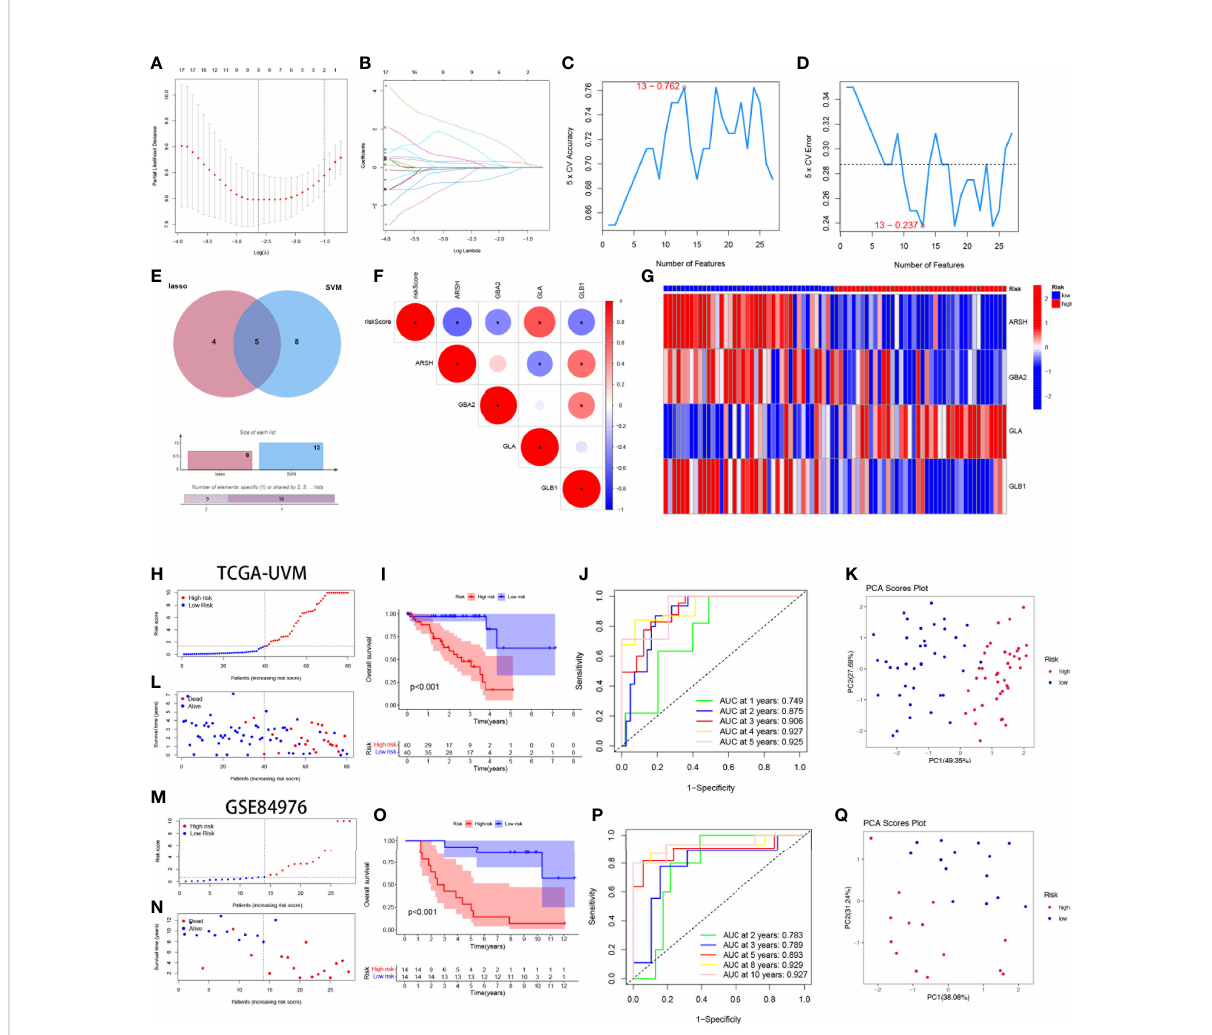
FIGURE 3 Construction and validation of 4-SMGs Signature. (A) Ten ‐ time cross ‐ validation for tuning parameter selection in the LASSO model. (B) LASSO coef fi cient pro fi les. (C, D) Biomarker signature gene expression validation by SVM-RFE algorithm selection. (E) Two algorithmic venn diagram screening genes. (F) Correlation of 4-SMGs with riskscore. (G) Heatmap of risk factors in high- and low-risk patients. (H) Distribution of risk scores between low- and high-risk groups in the TCGA cohort. (I) Survival status of UVM patients in the low- and high-risk groups in the TCGA cohort. (J) KM curve compares the overall UVM patients between low- and high-risk groups in the TCGA cohort. (K) Time-dependent ROC curves analysis in the TCGA cohort. (L) PCA plot in the TCGA cohort. (M) Distribution of risk scores between low- and high-risk groups in the GEO cohort. (N) Survival status of UVM patients in the low- and high-risk groups in the GEO cohort. (O) KM curve compares the overall UVM patients between low- and high-risk groups in the GEO cohort. (P) Time-dependent ROC curves analysis in the GEO cohort. (Q) PCA plot in the GEO